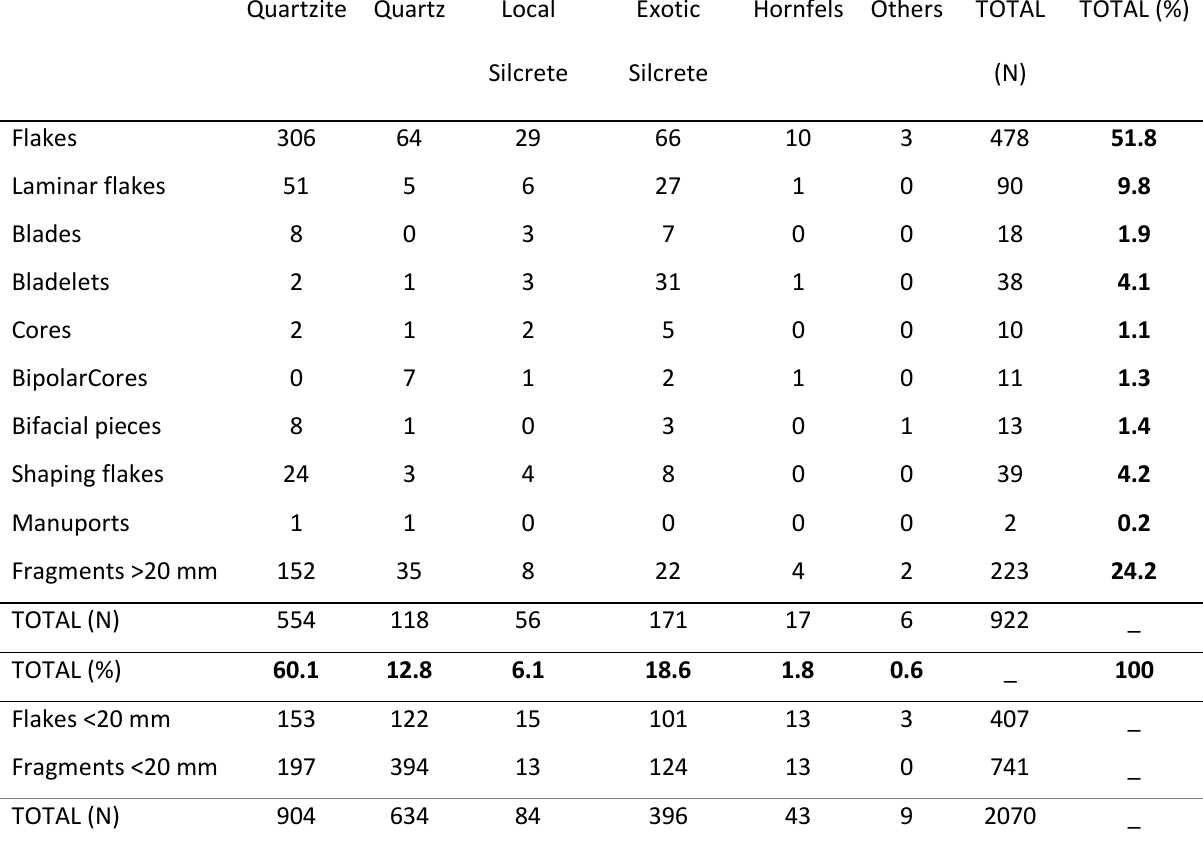
Table 1 . Lithic assemblage from the stratigraphic unit Lynn per raw material (Diepkloof Rock Shelter) (all calculations in the text are based on products >20 mm). Formal tools are classified by their respective technological